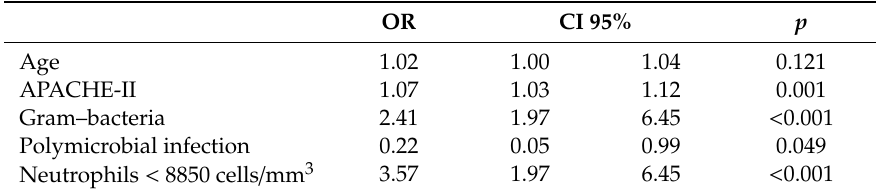
Table 3. Logistic regression analysis for predicting ICU mortality in the sCAP group with septic shock: lymphocyte count.